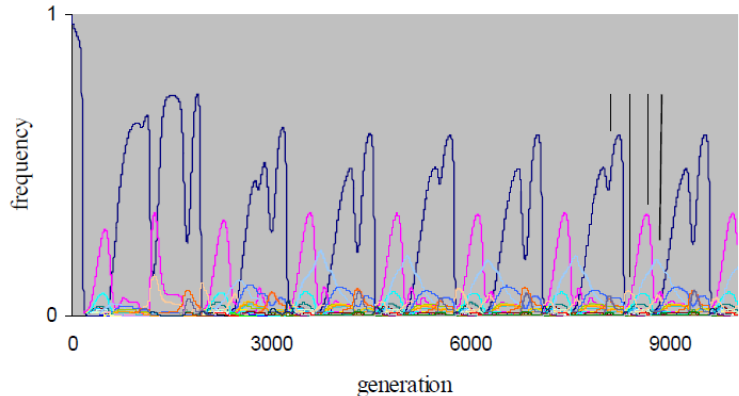
Figure 3. The frequency dynamics of an X4 -simulation at { P , µ } = {0.3, 0.01}; other conditions as in Figure 1. The four vertical lines indicate the position of a respective dominance phase of strategies { AllD , ddcdddddddddddd , TfT 1, dddddcddddddddd }.